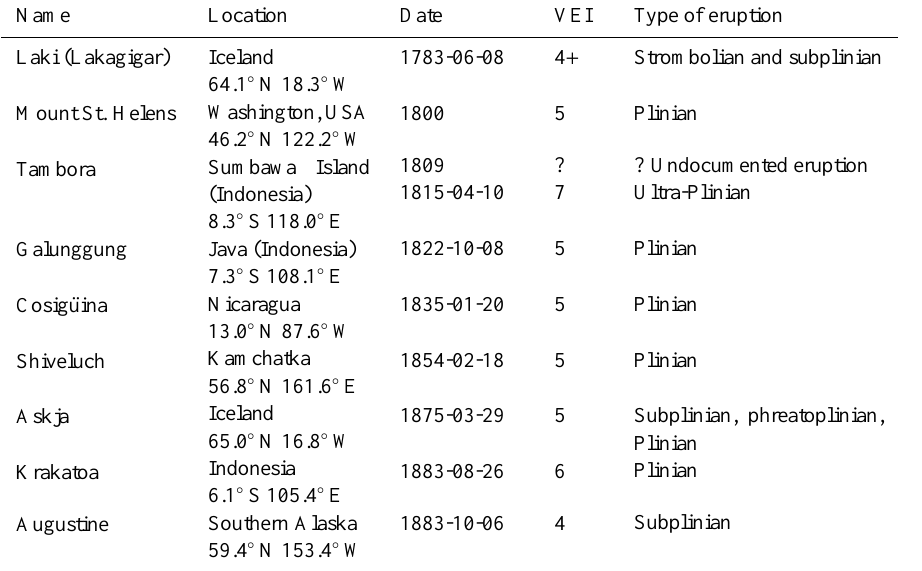
Table 1. The great eruptions occurred from 1783 to 1883 with a VEI equal to or more than 4 + . Exception is given for the Augustine eruption with VEI equal to 4 to demonstrate the complexity of the volcanic activity in 1883. After Newhall and Self (1982), Zielinski et al. (1994), Cole-Dai et al. (2009) and Siebert et al.